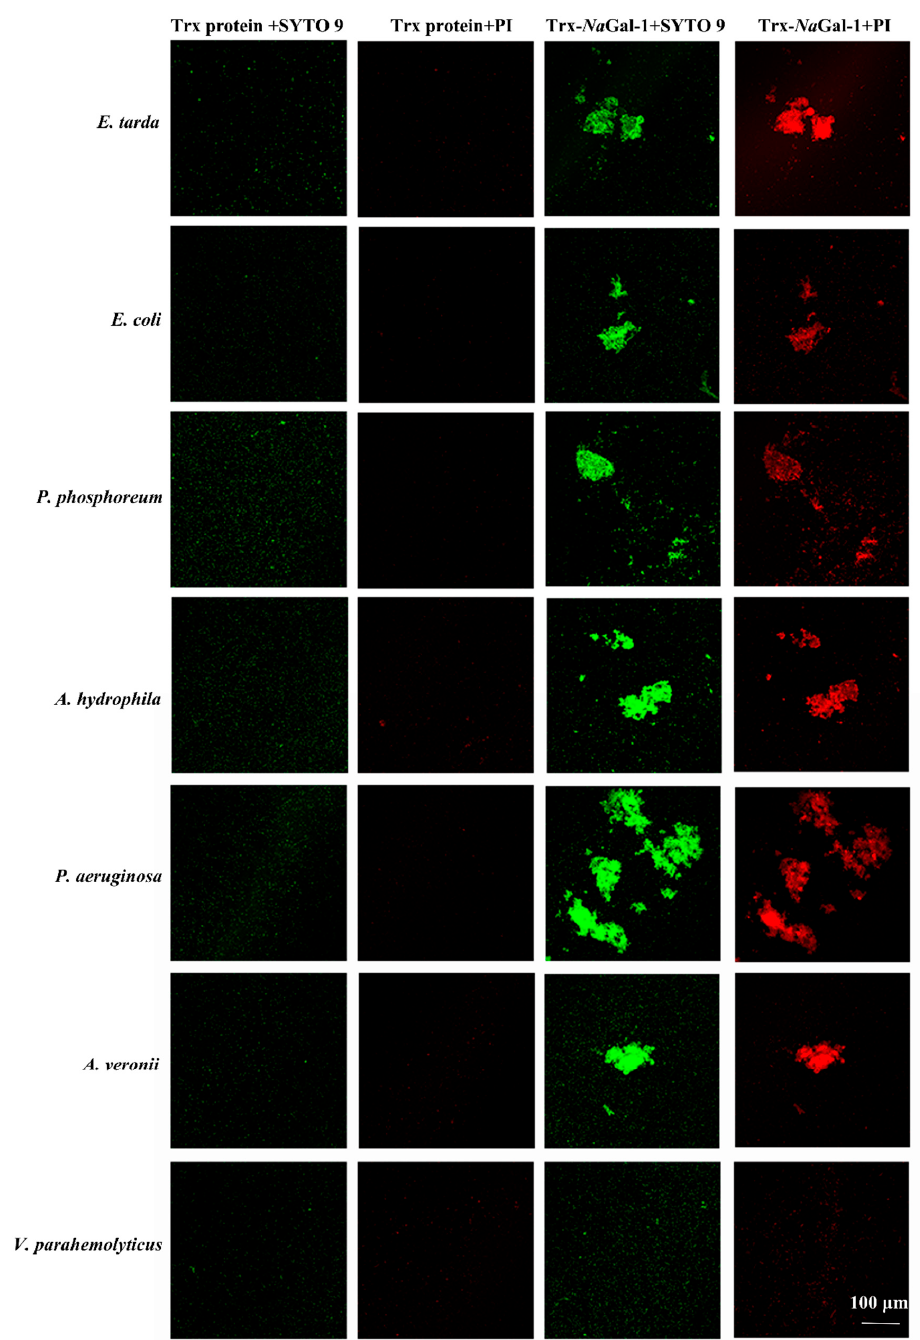
Figure 8. Bacterial agglutination and antibacterial activity of Trx ‐ Na Gal ‐ 1 protein. Agglutinated and dead bacteria: E. tarda , E. coli , P. phosphoreum , A. hydrophila , P. aeruginosa , and A. veronii , and non ‐ agglutinated bacteria representative: V. parahemolyticus . All the bacteria stained by SYTO 9 were in green and dead bacteria stained by propidium iodide (PI) were in red.